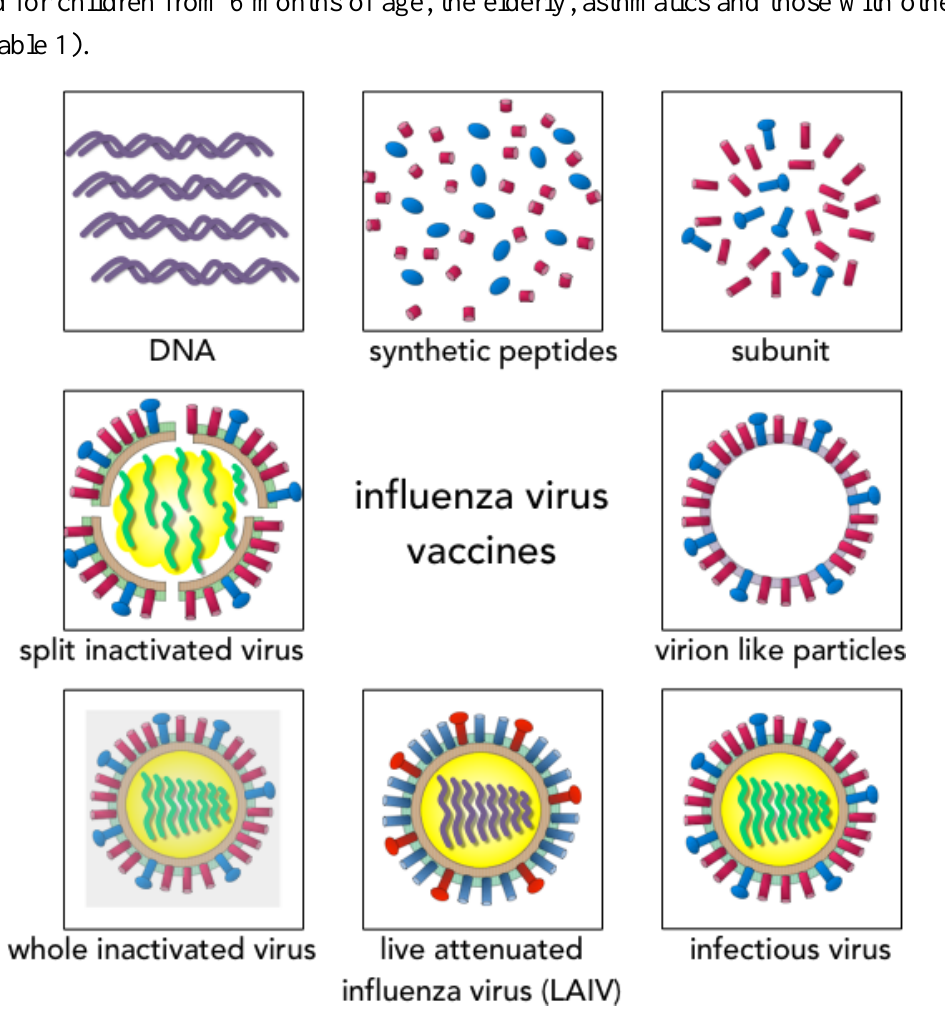
Figure 2. The different formulations of influenza vaccine. Currently licensed influenza vaccines are predominately inactivated virus (whole inactivated, split, subunit or virion like particle) or live attenuated influenza vaccine. Novel vaccines are DNA or synthetic peptide